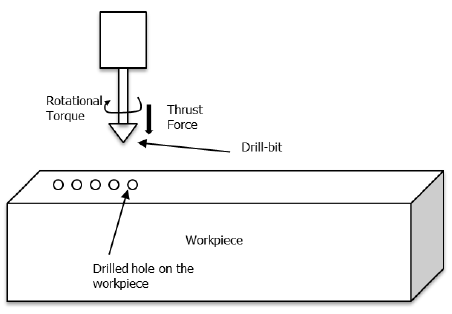
Figure 1. Illustration of experimental setup showing the controlled drill-bit, sequential drilling on the workpiece, rotational torque, and thrust force.